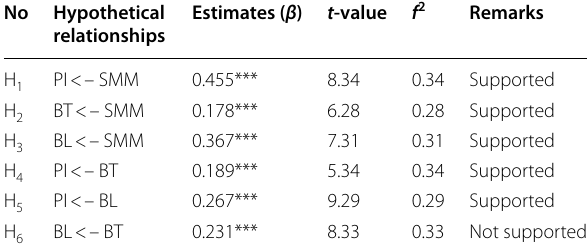
Table 4 Results of PLS-SEM Source : Primary